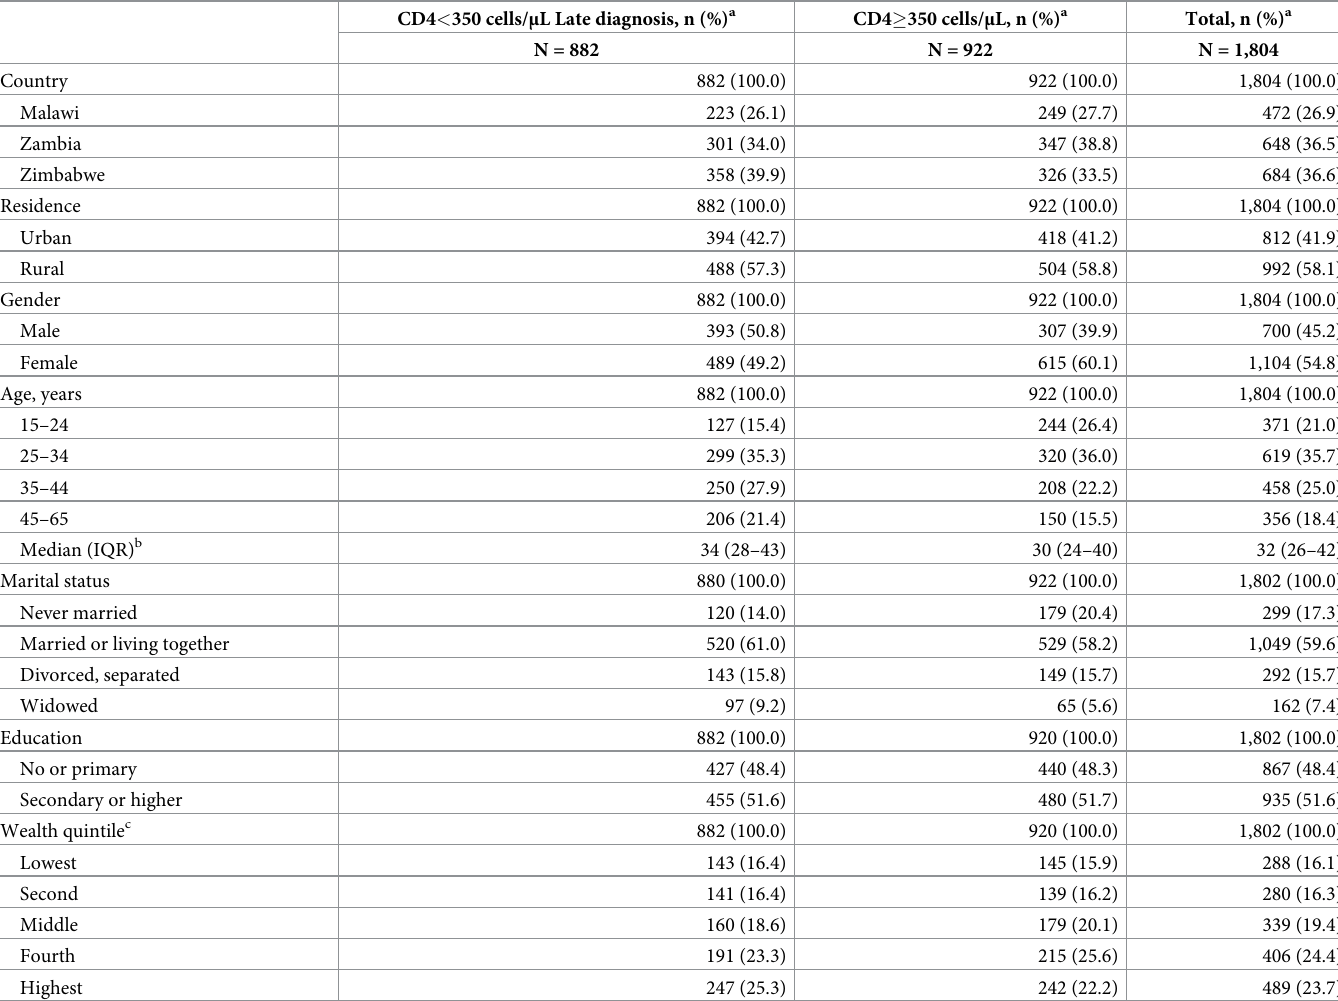
Table 1. Sociodemographic characteristics of adults diagnosed with HIV during the survey in Malawi, Zambia, and Zimbabwe (2015–2016) a . CD4 < 350 cells/ μ L Late diagnosis, n (%)